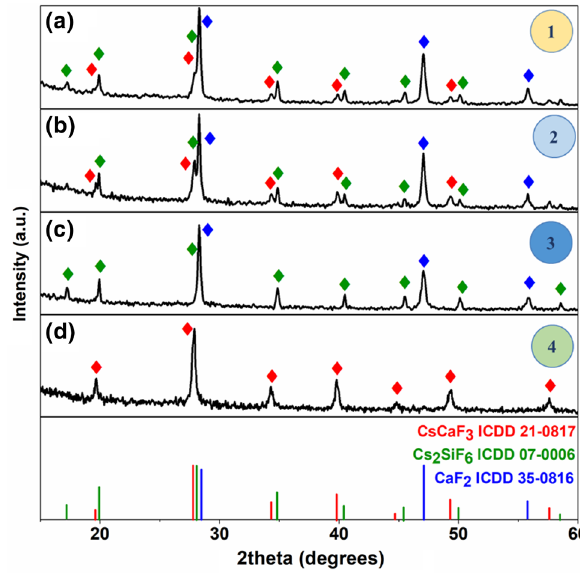
Scheme 1 Scheme of the sol–gel/spin-coating process of CsCaF annealing temperature